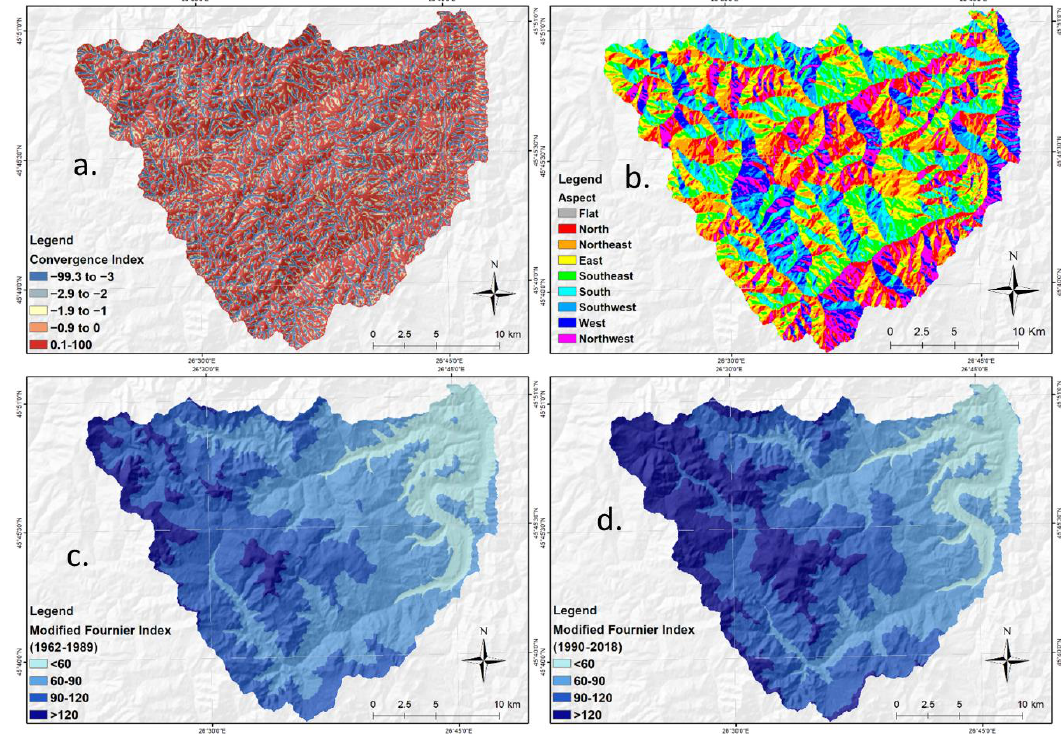
Figure 5. The factors considered for the FFPI calculation: ( a ) convergence index, ( b ) aspect, ( c ) modified Fournier index (1989), and ( d ) modified Fournier index (2019).